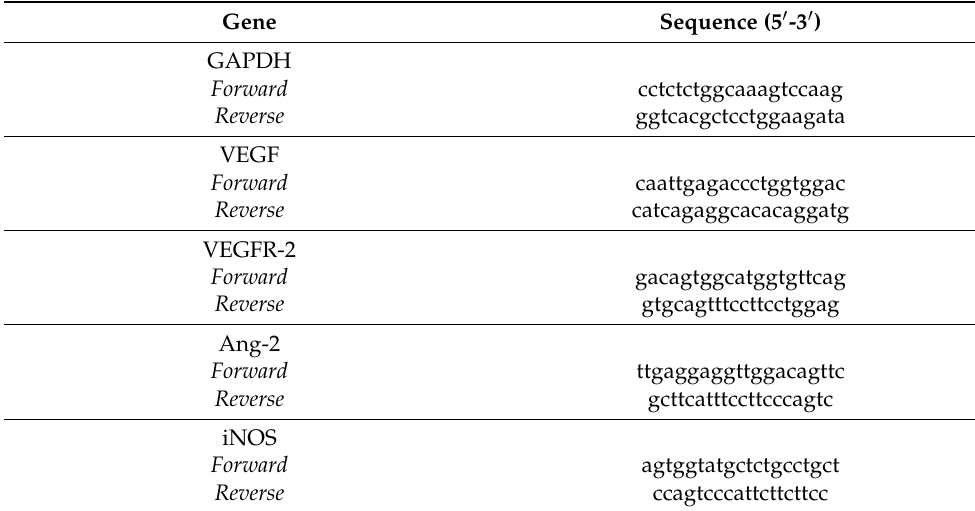
Table 2. Oligonucleotide primers used for RT-PCR analysis.